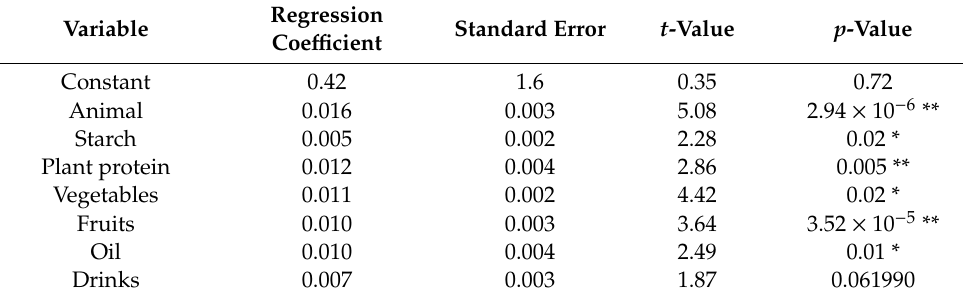
Table 4. Hemoglobin regression